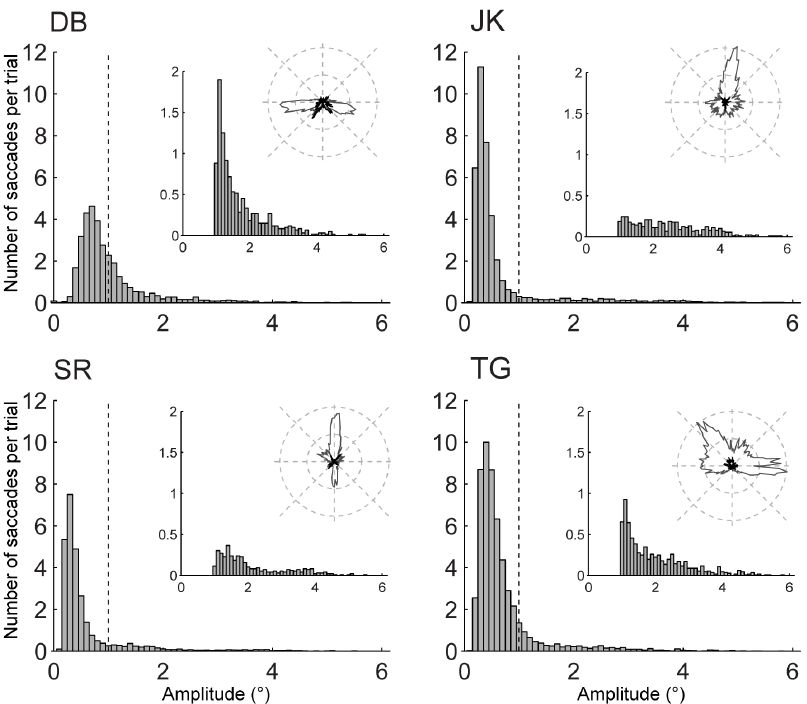
Figure 4. Distribution of saccade amplitudes in saccade trials for each subject. Bin size 0.1 u . Insets show the distribution of saccades . 1 u on a different scale and polar histograms of saccade direction for small (gray) and large (black) saccades.